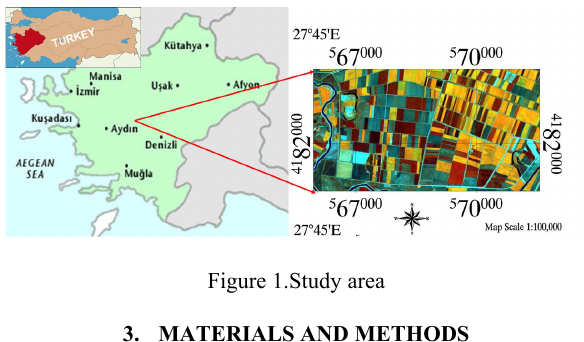
Figure 1.Study area